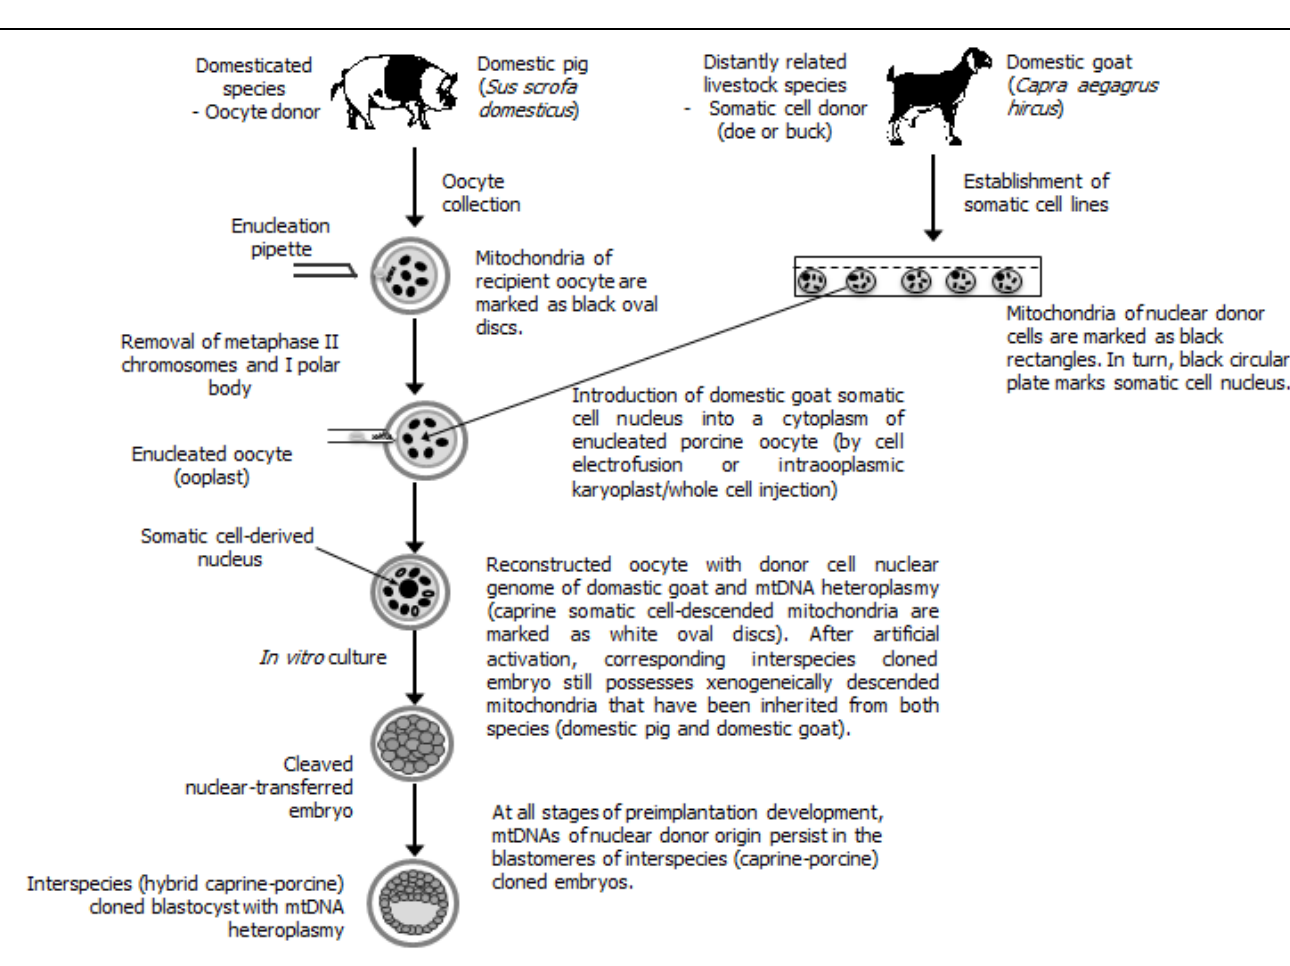
Figure 3. Interspecies (interfamily and intergenus) somatic cell cloning, in which nuclear donor cells and recipient oocytes are recovered from phylogenetically non-consanguineous species (i.e., domestic goat and domestic pig, respectively). Xenogeneic (heterologous) mitochondria that have been inherited from caprine nuclear donor cells and porcine recipient oocytes coexist during preimplantation development of interspecies (goat → pig) cloned embryos, leading to intracellular mtDNA heteroplasmy at the blastocyst